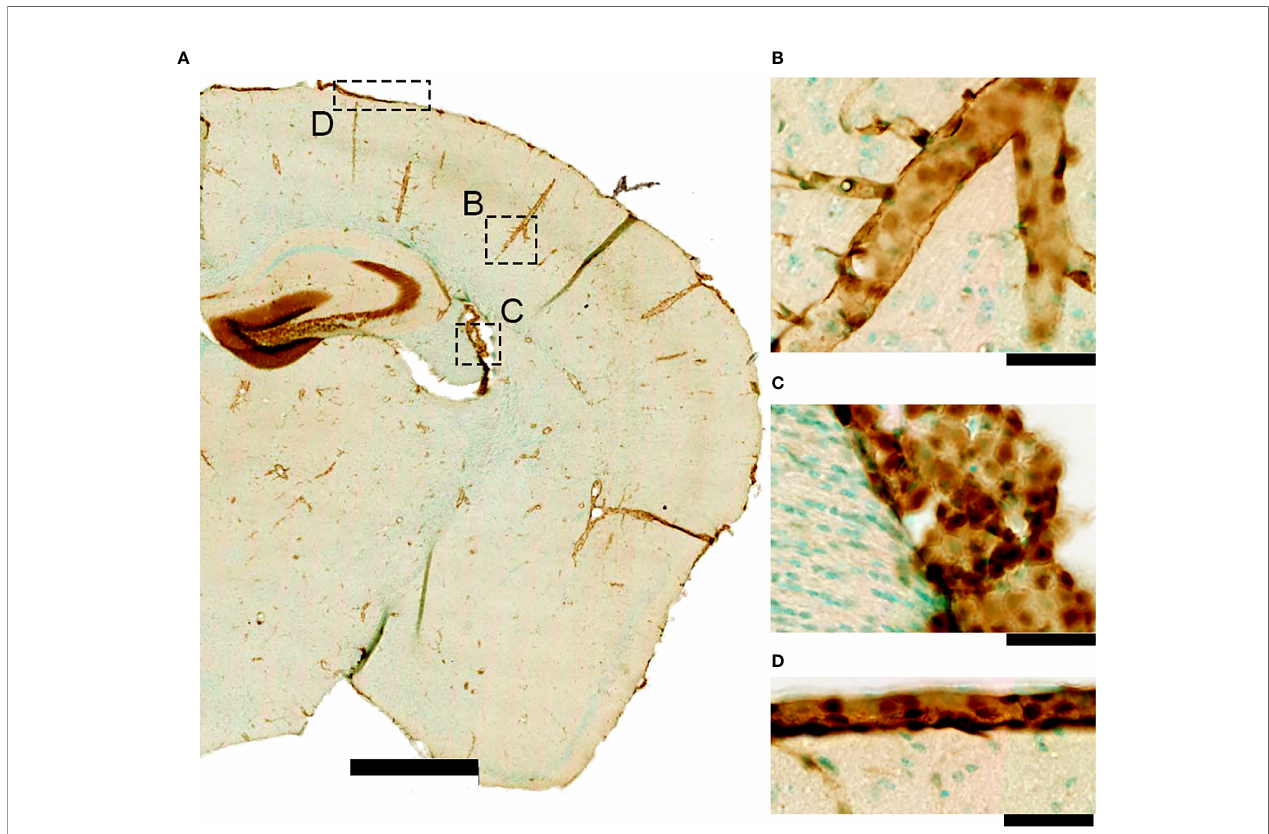
FIGURE 2 | IL-1R1 gene expression in a naïve adult reporter mouse. (A) The IL-1R1 reporter mouse line expresses RFP via the IL-1R1 promoter (77) in discrete tissue compartments as seen using RFP immunohistochemistry. (B) IL-1R1 expression is high in blood vessels within the brain parenchyma, (C) choroid plexus, and (D) meninges. All of these areas are associated with one of the CNS barriers. (scale bar is 1mm in A, and 50 m m in B – D